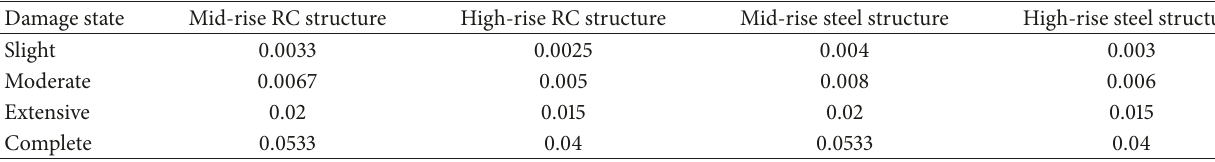
Table 1: Interstory drift values for the damage states [1].